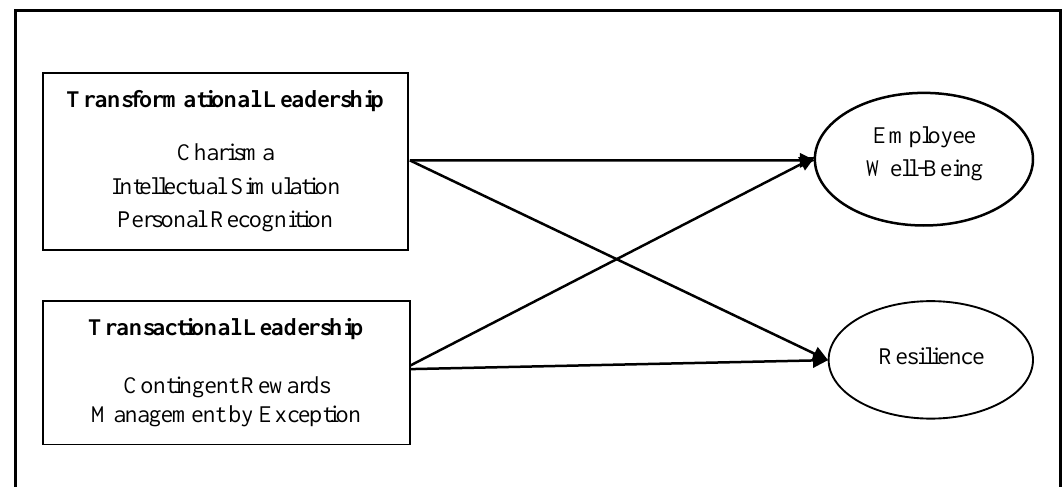
Figure.1. Conceptual Model of the